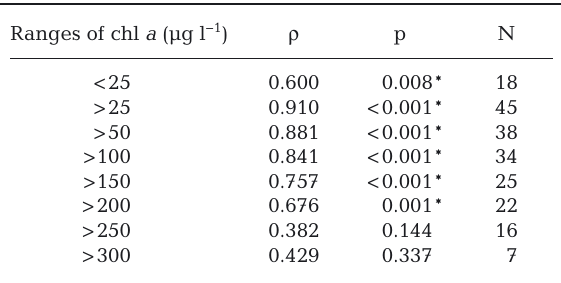
Table 2. Spearman correlation results between ranges of chlorophyll a (chl a ) measured by the fluorometer and the FluoroProbe. *p < 0.01 Ranges of chl a (µg l −1 )